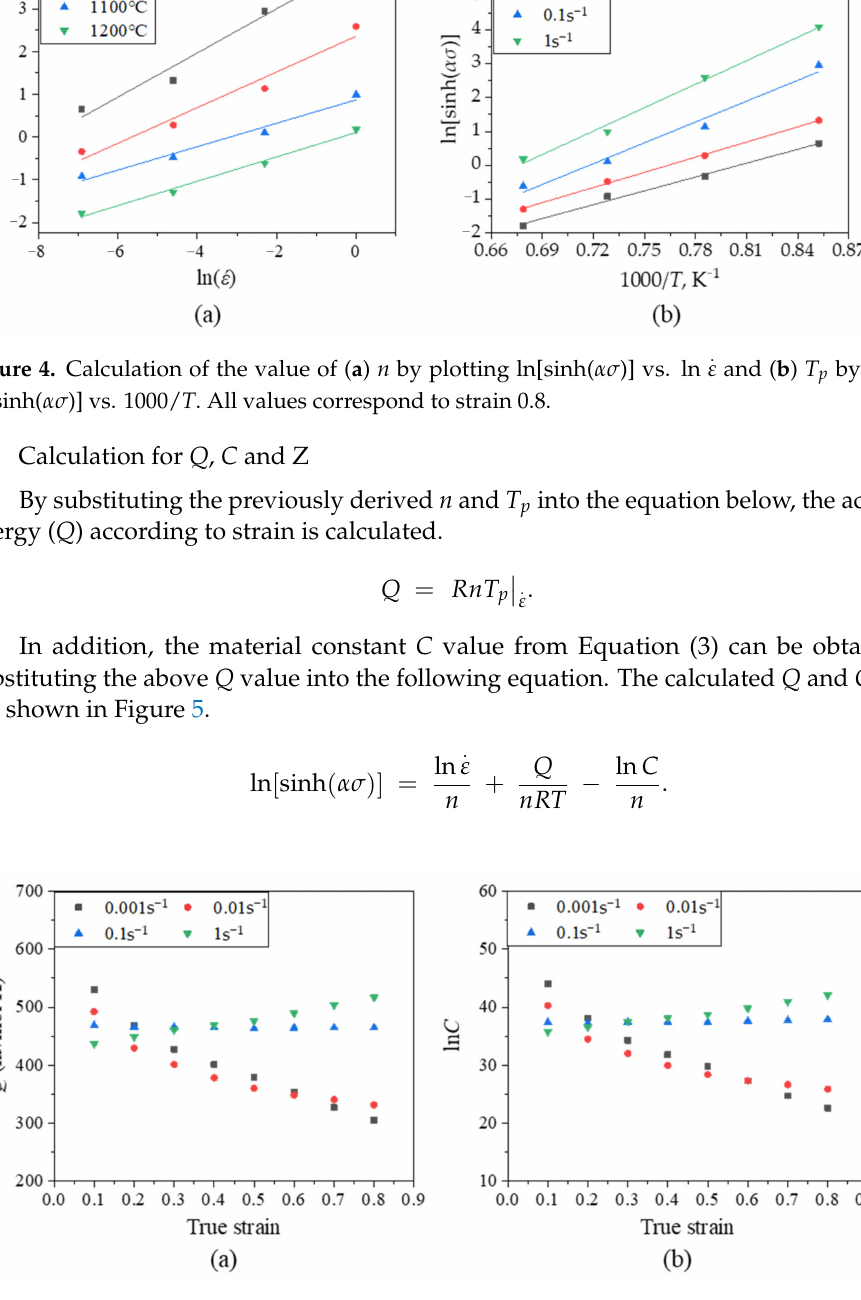
Figure 5. Calculated material constants of ( a ) deformation activation energy and ( b ) ln C